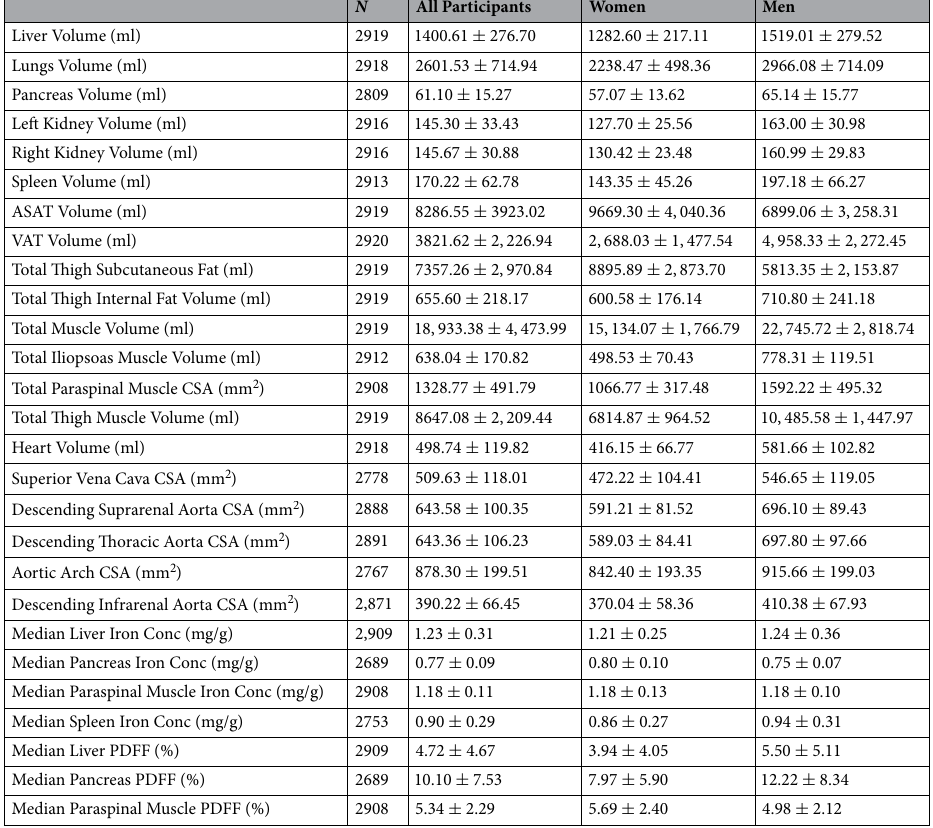
Table 4. Summary of IDPs at the first imaging visit for all participants, and separated by gender. Values are reported as mean and standard deviation. ASAT: abdominal subcutaneous adipsose tissue; Conc: concentration; CSA: cross-sectional area; PDFF: proton density fat fraction; VAT: visceral adipose